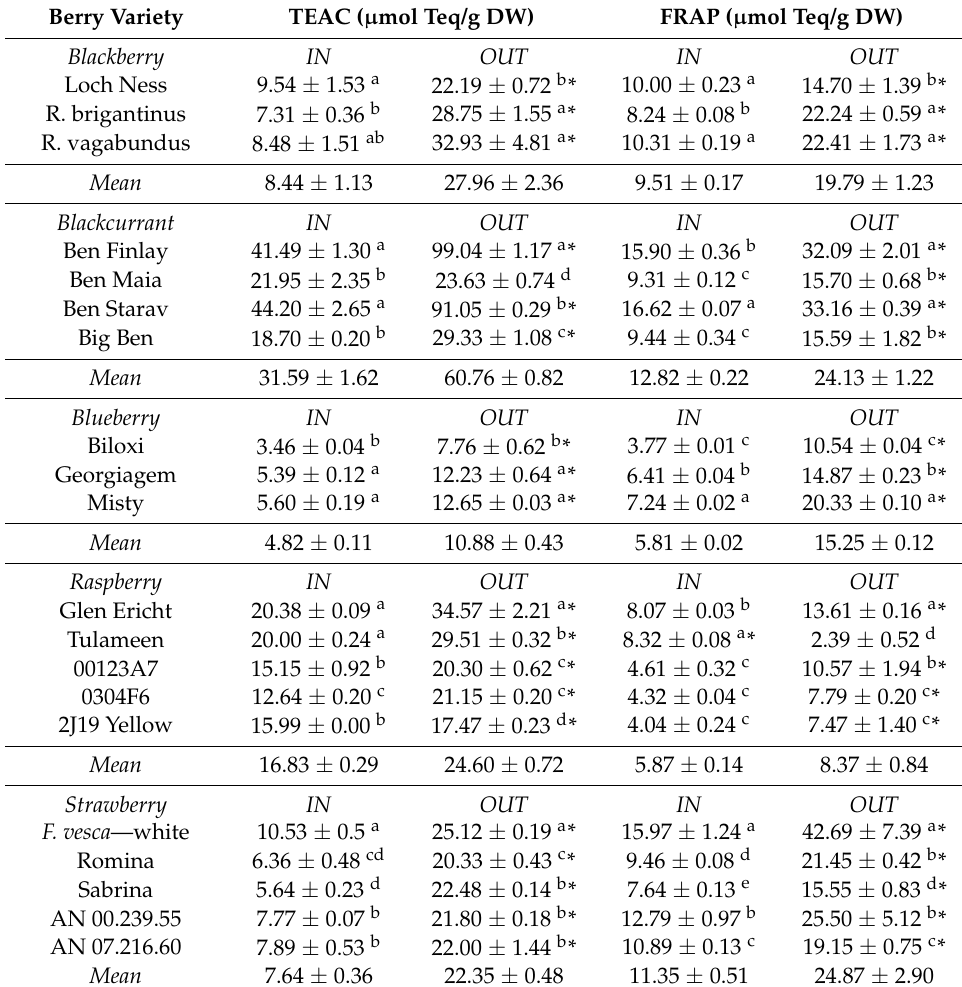
Table 2. Total antioxidant capacity of the “IN” and “OUT” samples from different berries following the in vitro